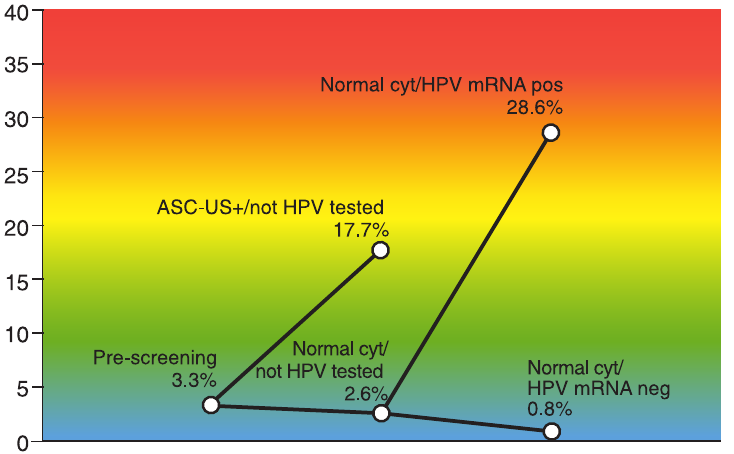
Fig 2. The difference in risk of CIN3+ at specific branching points of the study. CIN3+ = CIN3, ACIS and cervical